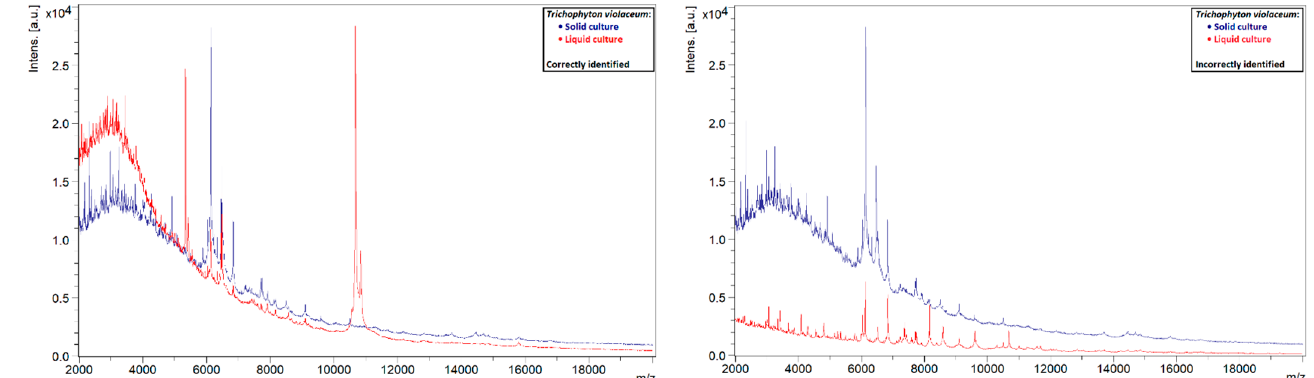
Figure 8. Comparison of the spectra of solid and liquid cultures of a T. violaceum strain, on the left a correctly identified liquid culture and on the right an incorrectly identified liquid culture.